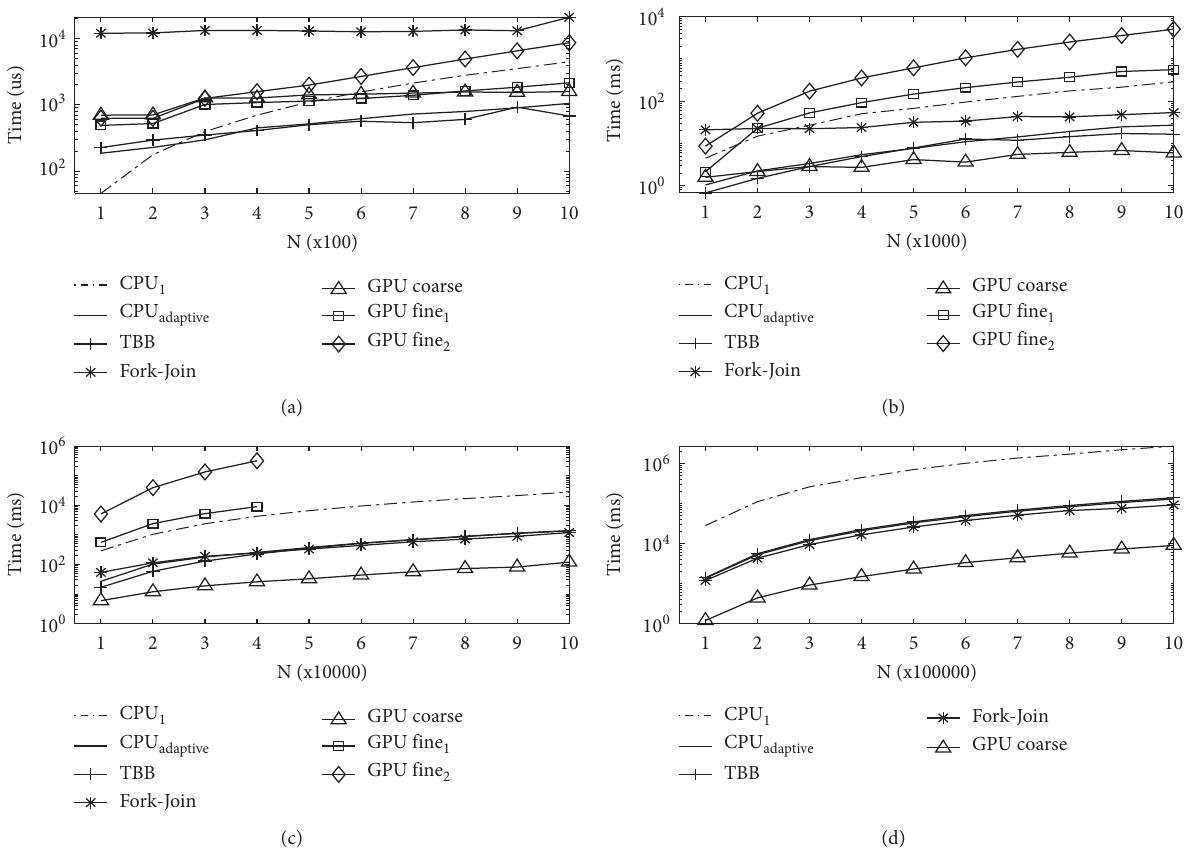
Figure 4: Performance comparison of Sections 2.1–2.7 in different problem sizes. (a) Microsecond is used as the time unit; (b)–(d) millisecond is used as the time unit; the Y -axis uses logarithmic coordinates.